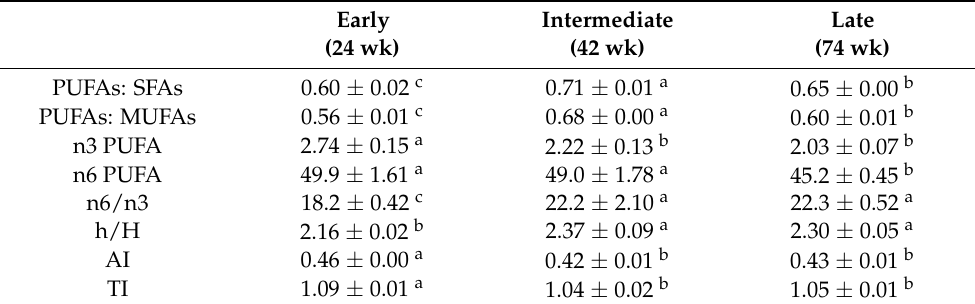
Table 3. The fat quality indices of lipids in the eggs of early (24 wk), intermediate (42 wk), and late-age laying (74 wk)